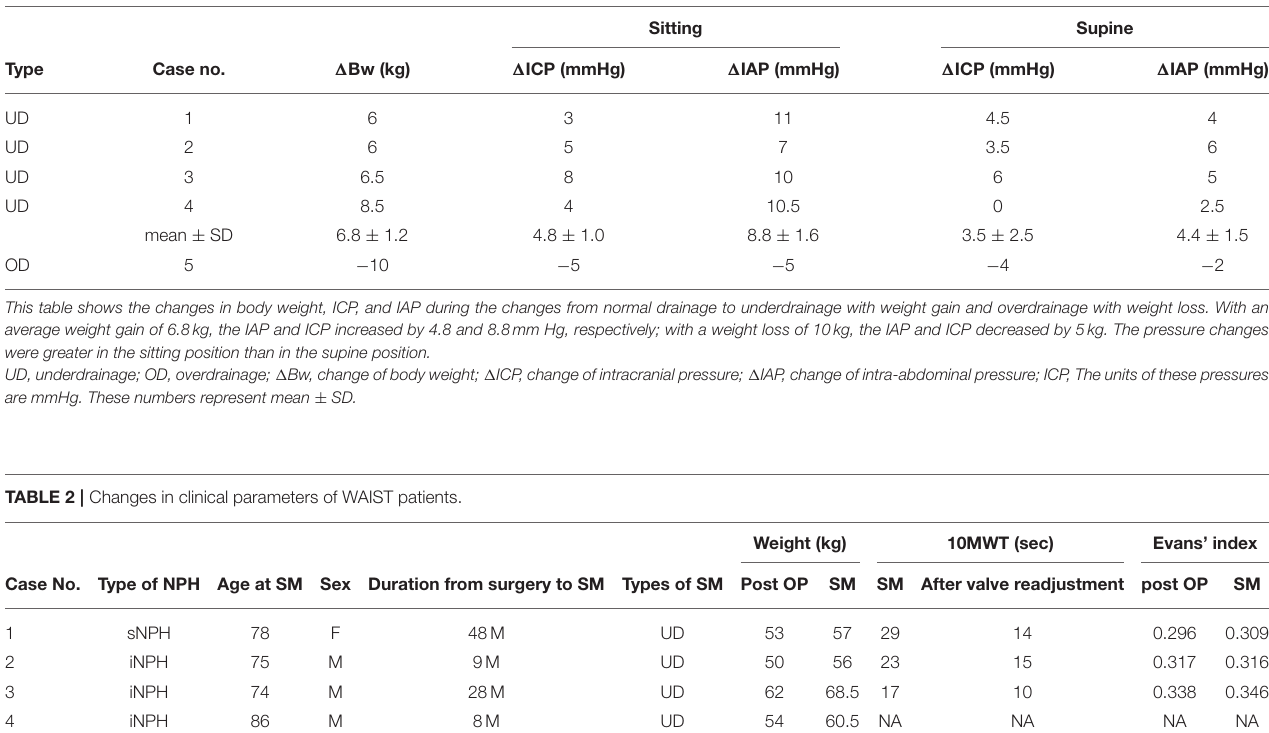
TABLE 1 | Changes in body weight and shunt-related pressures at the time of shunt malfunction.